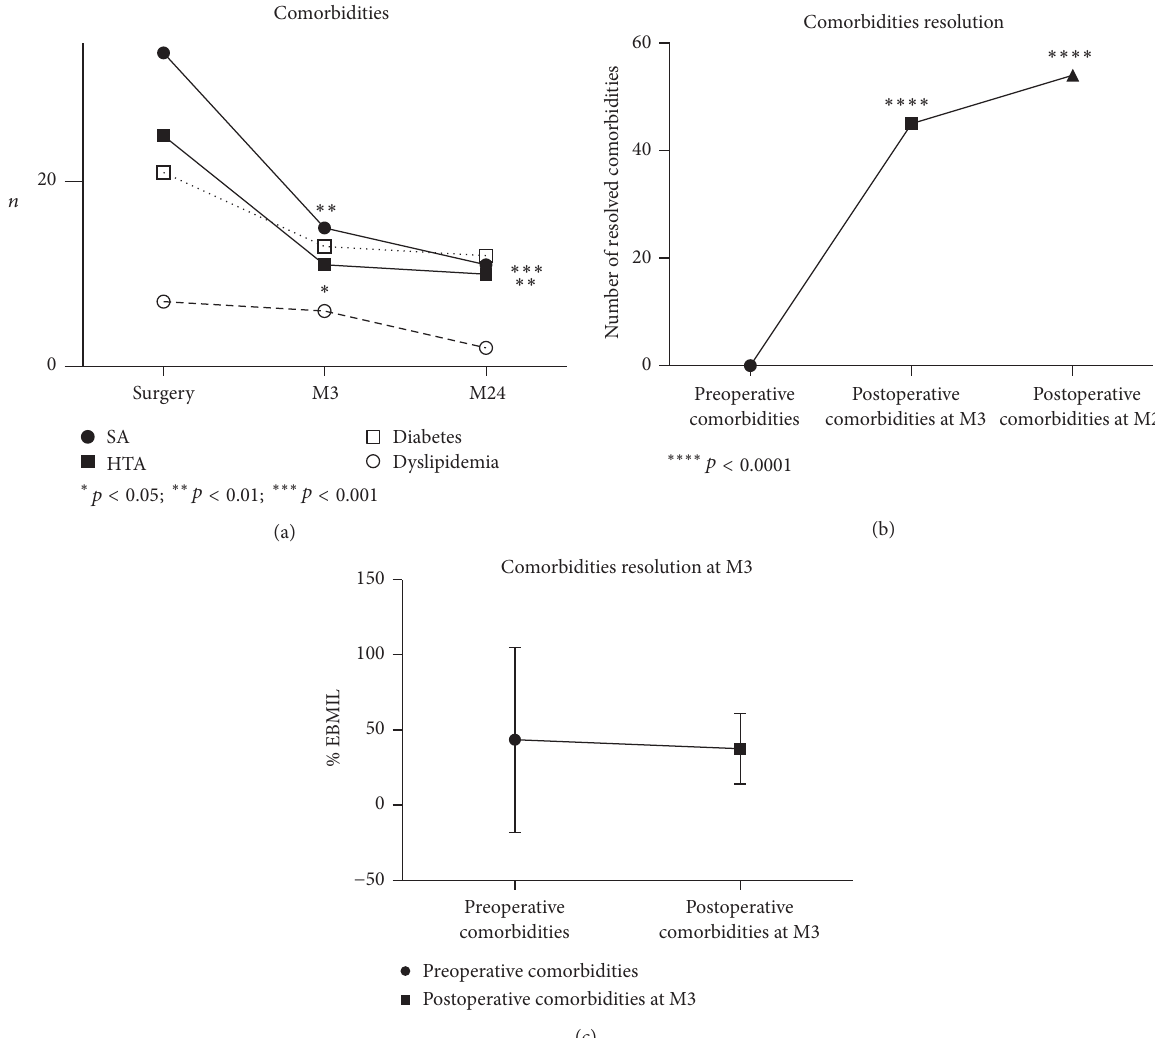
Figure 5: Evolution of comorbidities. (a) Evolution of comorbidities in preoperative time and three months and two years after surgery. SA: sleep apnea; HTA: hypertension; M3: at 3 months; M24: at 24 months. (b) Resolution of comorbidities at M3 and M24 for all comorbidities of 54 patients presenting with at least one preoperative comorbidity. M3: at 3 months; M24: at 24 months. (c) Relationship between Excess Body Mass Index Loss (% EBMIL) and resolution of comorbidities. M3: at 3 months.